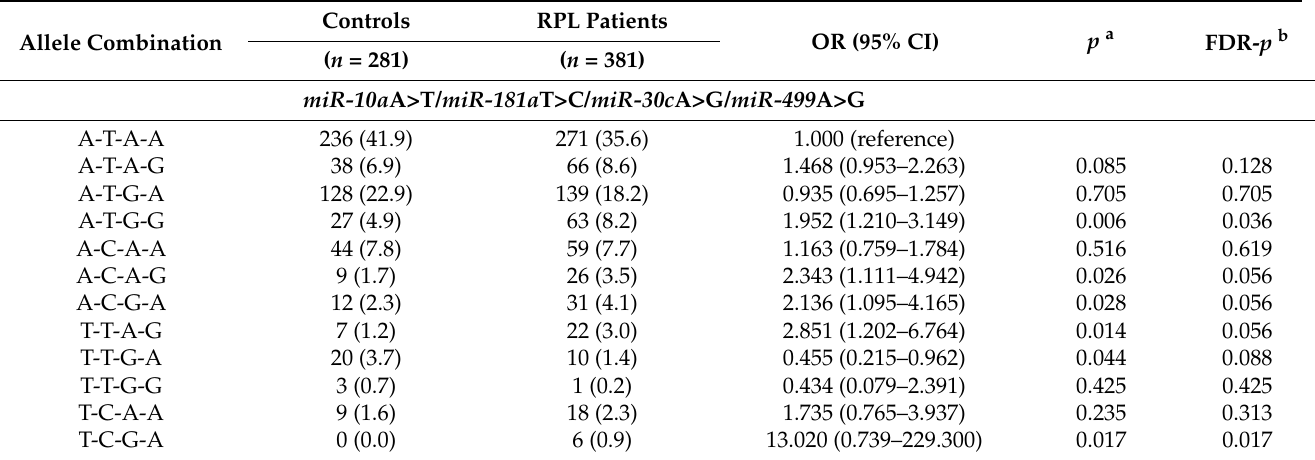
Table 6. Differences of various clinical parameters according to miRNA polymorphisms in RPL patients.